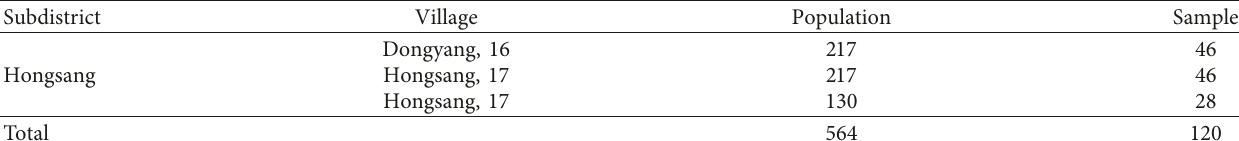
Table 7: The population and sample used in the study of the Huay Ling